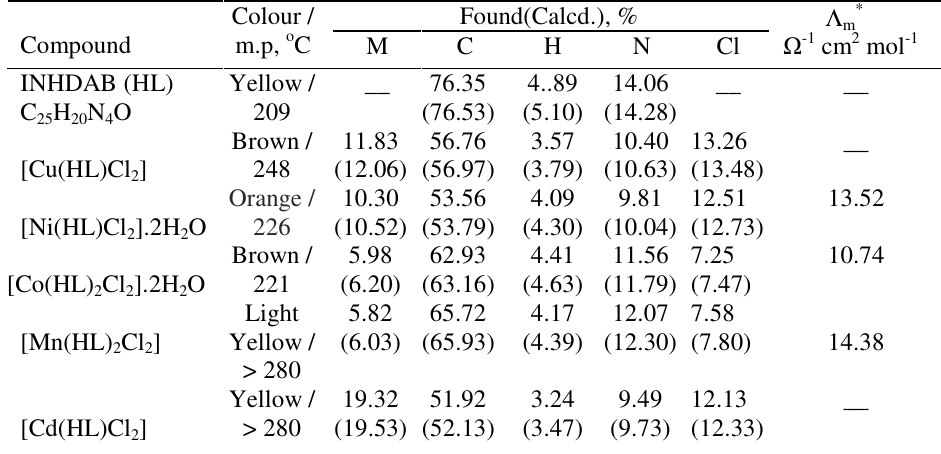
Table 1. Analytical and physical data of the complexes.